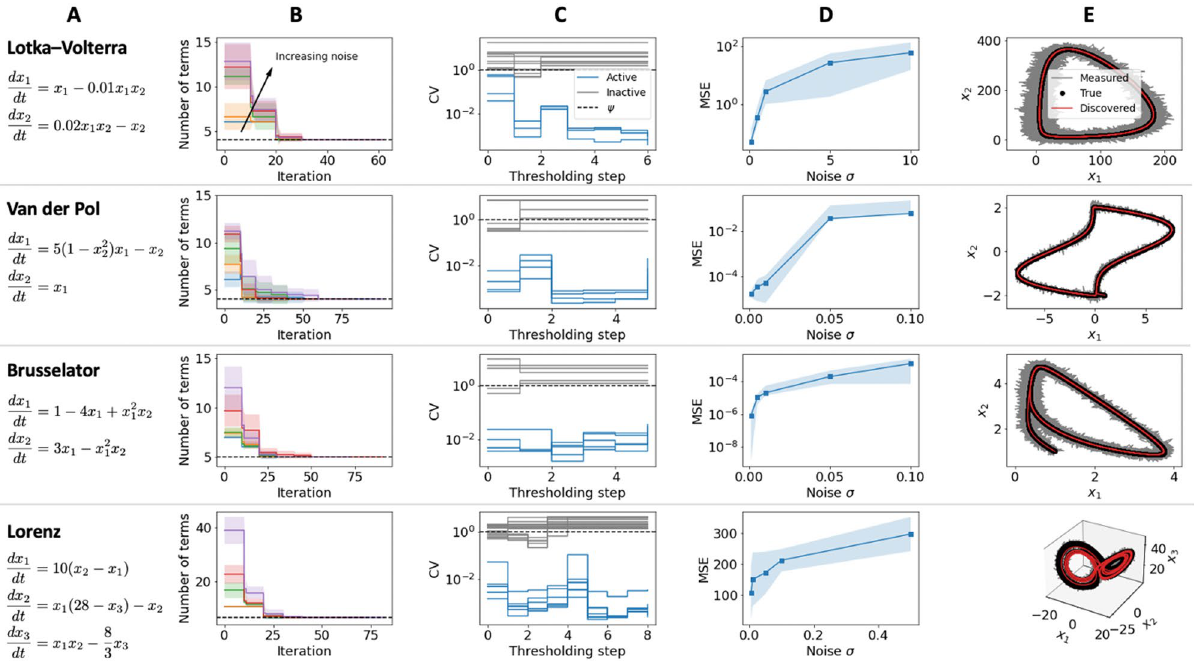
Figure 2. Numerical experiments on canonical nonlinear dynamical systems with governing equations of the T �( x T ) T form of ˙ x = � . ( A ) System name and true governing equations. ( B ) Mean number of basis functions in the discovered model as a function of iterations over 10 random samples of the simulated measurement data for each noise level considered (shaded area corresponds to two standard deviations from the mean, dashed black line is used to indicate the number of terms in the true dynamics). Two-dimensional systems were initialized with 28 basis functions, and 3-dimensional systems with 66 (See Supplementary Information for further details). ( C ) Coefficient of variation for each basis function after each thresholding step (results correspond to the highest noise setting considered for each system). ( D ) Average mean squared error (MSE) between simulations of the true dynamics and the discovered dynamics. ( E ) Comparison of discovered dynamics against true model and measured data (results correspond to the highest noise setting considered for each